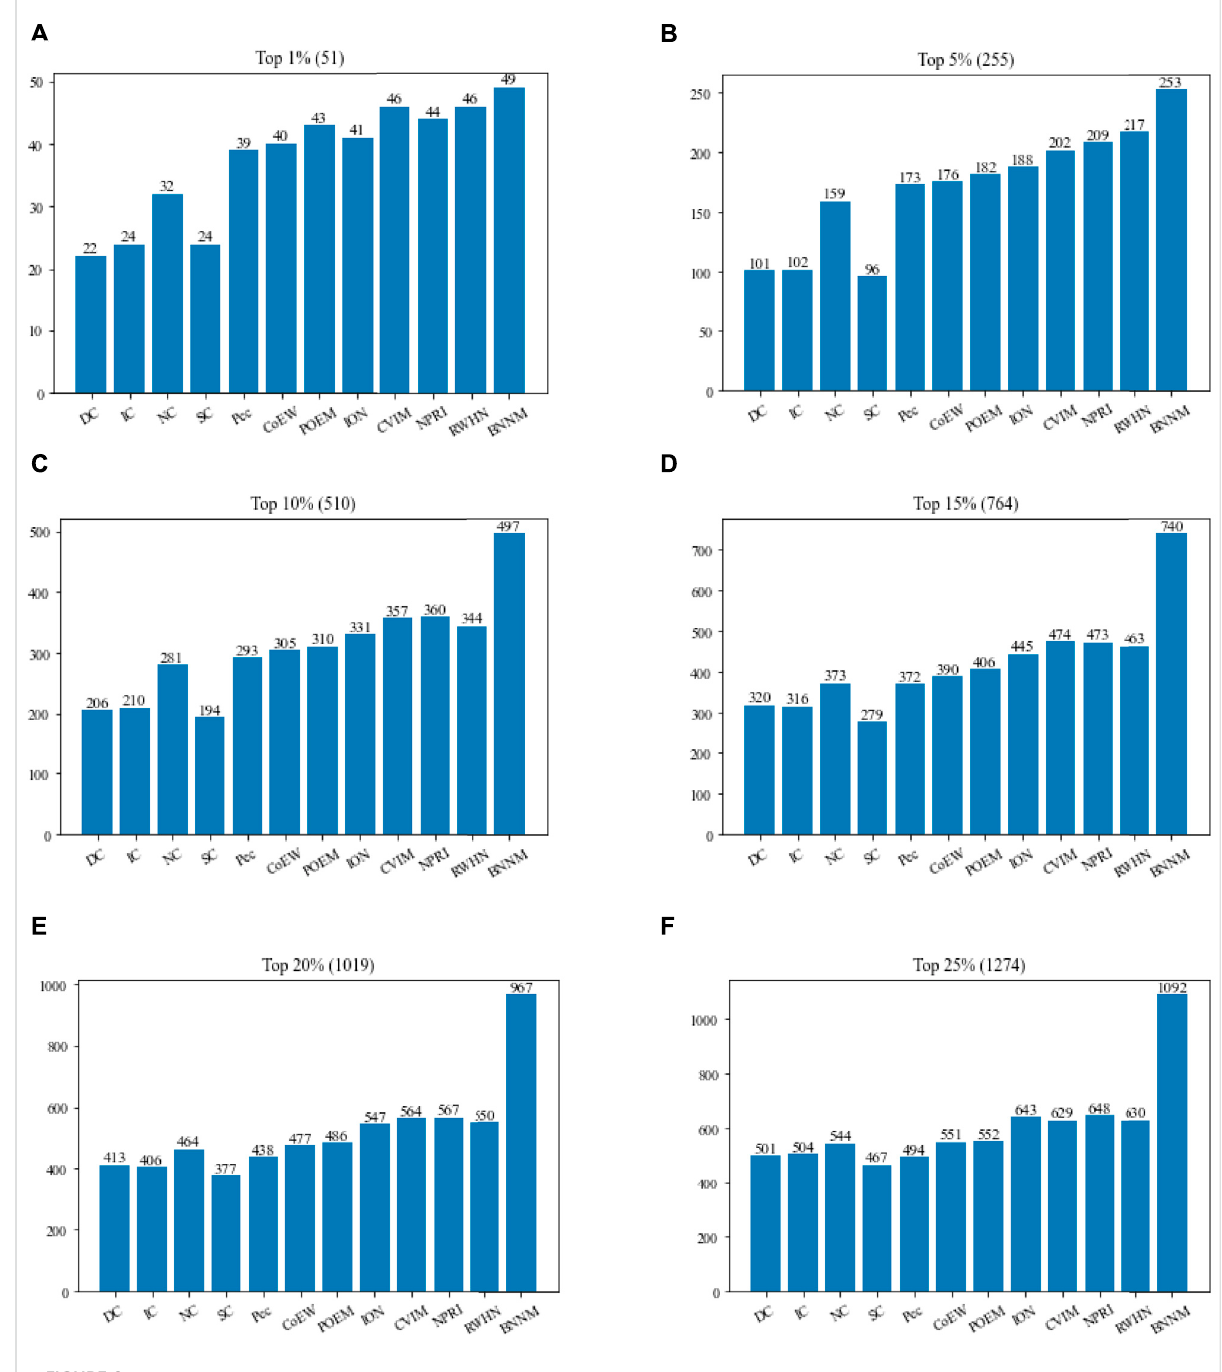
FIGURE 2 Comparison between TNNM and 11 competitive methods based on the DIP 2010. (A) The number of key proteins in the top 1% candidate proteins. (B) Number of key proteins in the top 5% candidate proteins. (C) Number of key proteins in the top 10% candidate proteins. (D) Number of key proteins in the top 15% candidate proteins. (E) Number of key proteins in the top 20% candidate proteins. (F) Number of key proteins in the top 25% candidate proteins. In above fi gures, the number in parentheses represents the number of proteins in each